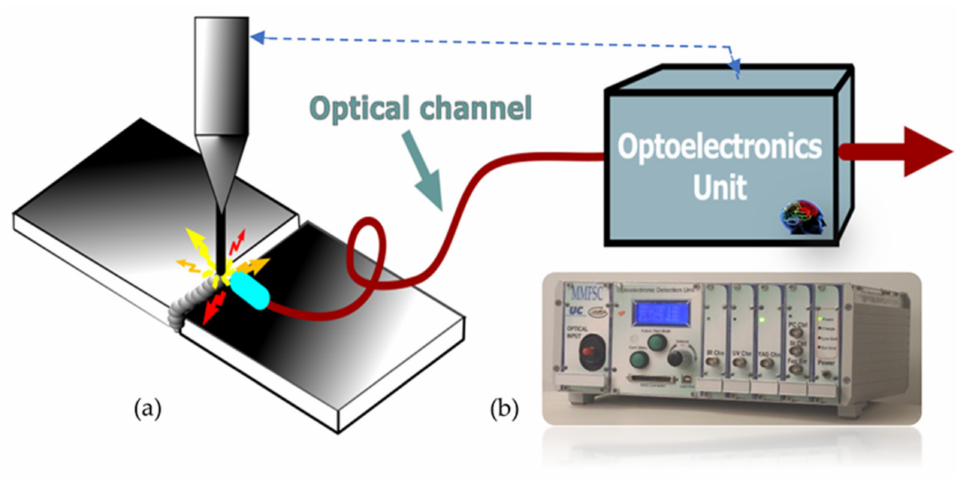
Figure 13. A general schematic illustration of a Smart Photonic Sensor for online welding monitoring. It is based on the spectrometry of the Light from plasmas of the welding pool and a significant level of signal processing. In the welding process of two materials using different sources of energy (laser, TIG, etc.), the borders of two materials are converted to a liquid state. During this process, plasma is created from the welding pool. Inside the spectra of the emitted Light (LM) are encoded information concerning the elements in the welding process at any time and on each welding position of the pool. After being detected and online spectra are determined by employing fast, complex, appropriate algorithms and Artificial Intelligence, welding defects can be determined online, and actuation signals can be supplied by the output of the optoelectronic unit. ( a ) General view of the SPS system; ( b ) a view of an optoelectronic unit for laser welding monitoring developed in the frame of the European MMFSC Project (GRD1-1999-10248). Made by the author based on material courtesy of the Photonic Engineering Group of